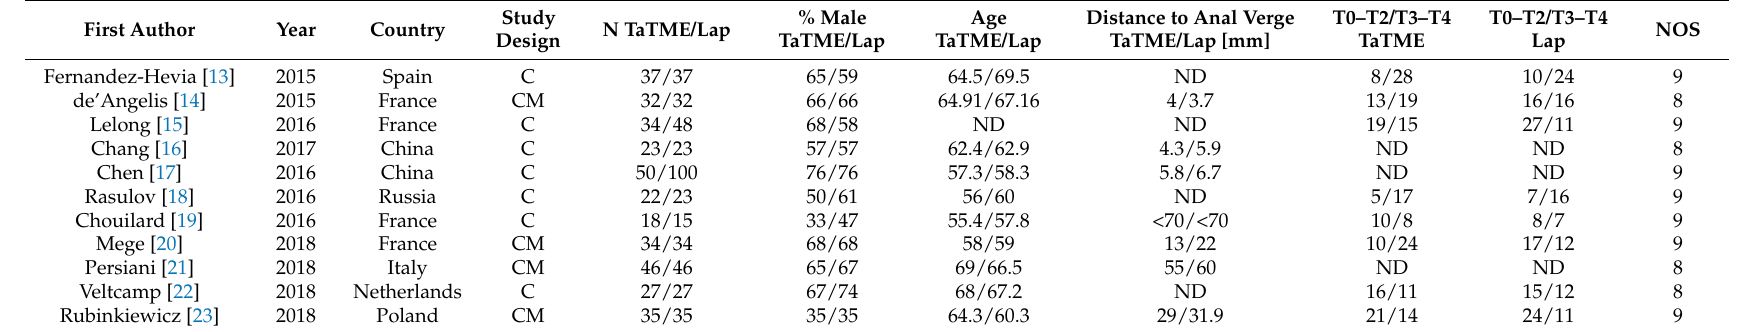
Table 1. Summary of included